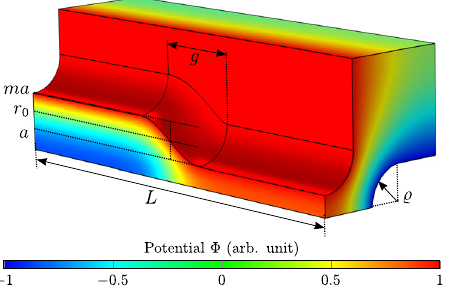
FIG. 7. Geometry and simulated electric potential of a trap- ezoidal RFQ cell.